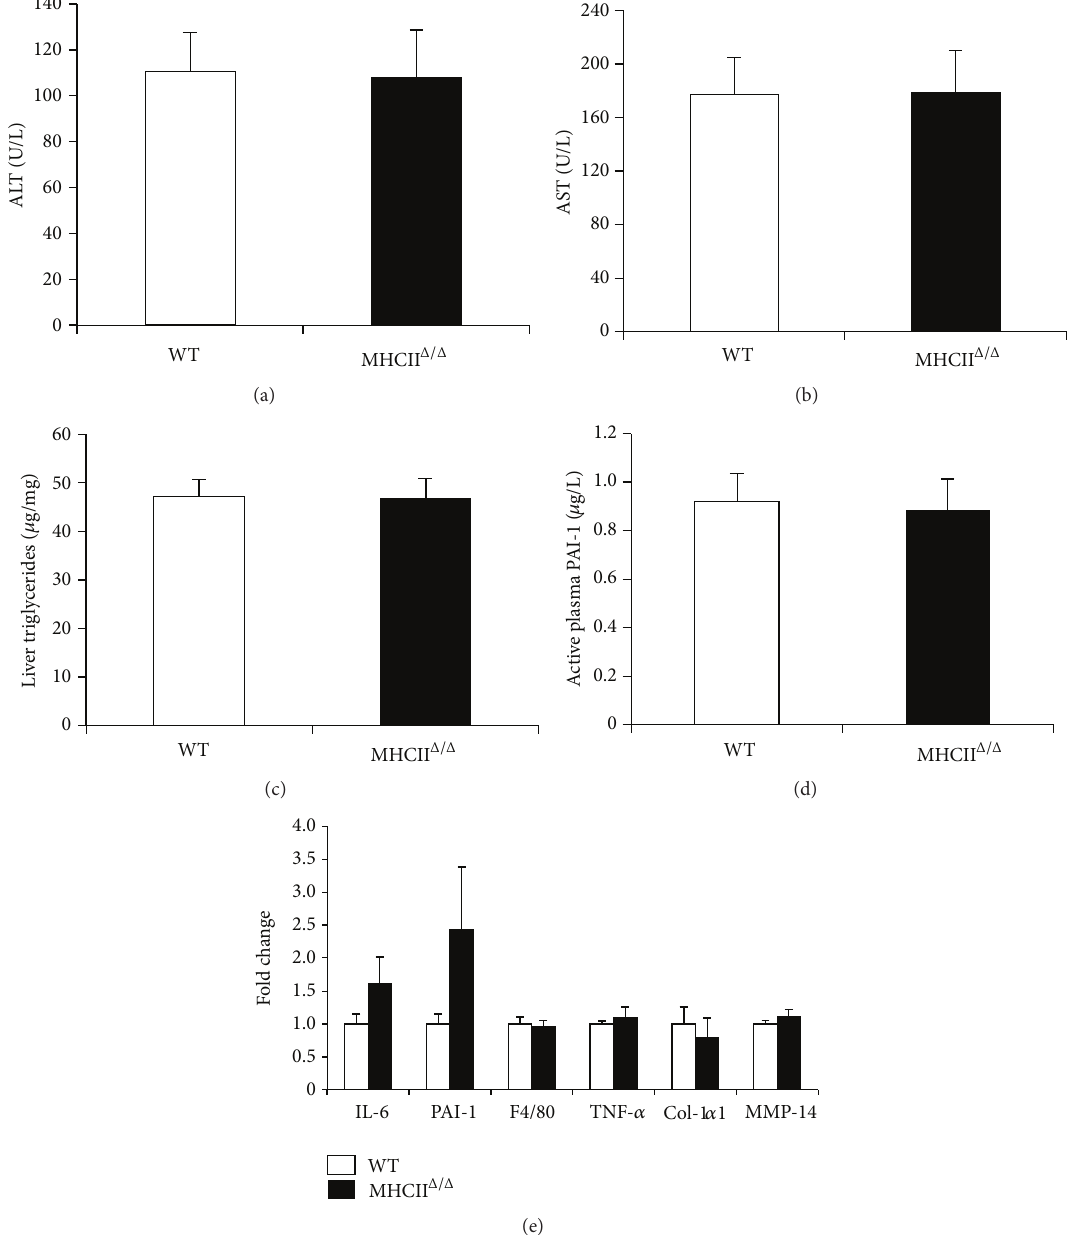
Figure 3: Effect of high-fat diet on liver enzymes, lipids, and inflammatory markers in wild-type and MHCII Δ/Δ mice. Open bars represent wild-type and closed bars MHCII Δ/Δ mice (wild-type: 𝑛 = 25 , MHCII Δ/Δ : 𝑛 = 20 ). Data are presented as mean ± SEM. (a) Plasma ALT level at 16th week. (b) Plasma AST level. (c) Liver triglyceride content at 16th week. (d) Fasting active plasma PAI-1 concentration at 16th week. (e) Gene expression related to inflammation and fibrogenesis in the liver at 16th